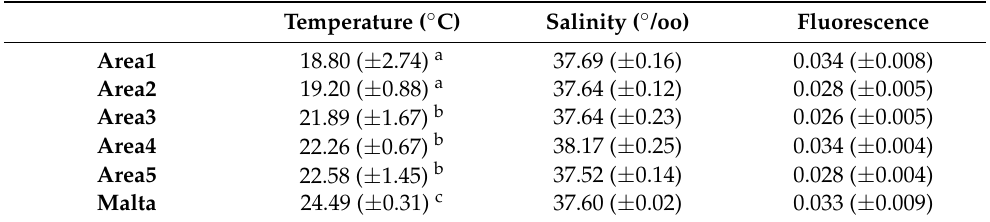
Table 1. Environmental conditions. Mean ( ± sd) temperature, salinity and fluorescence within the first 20 m. Different superscript letters after temperature values indicate statistically significant difference between pairs of areas (permutational pairwise t test, p -value < 0.05).